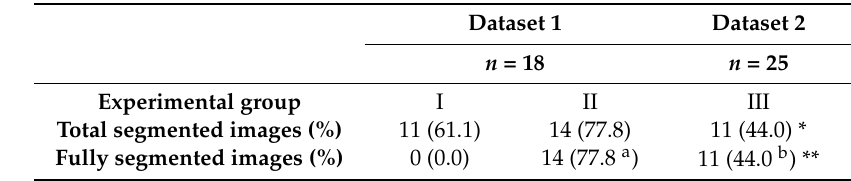
Table 1. Percentage of segmentation among experimental groups. Larger (Groups I and II) and smaller images (Group III) captured from a smartphone source were segmented with (Groups II and III) or without (Group I) the use of the scaling algorithm software. The observed frequency among the three groups were compared with Chi-square, whereas Groups II and III (fully segmented images) with Fisher Exact